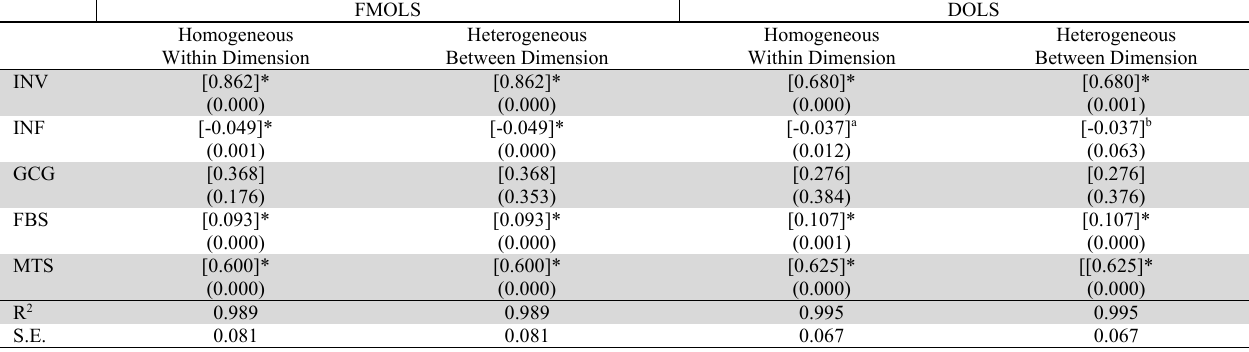
Panel FMOLS and DOLS